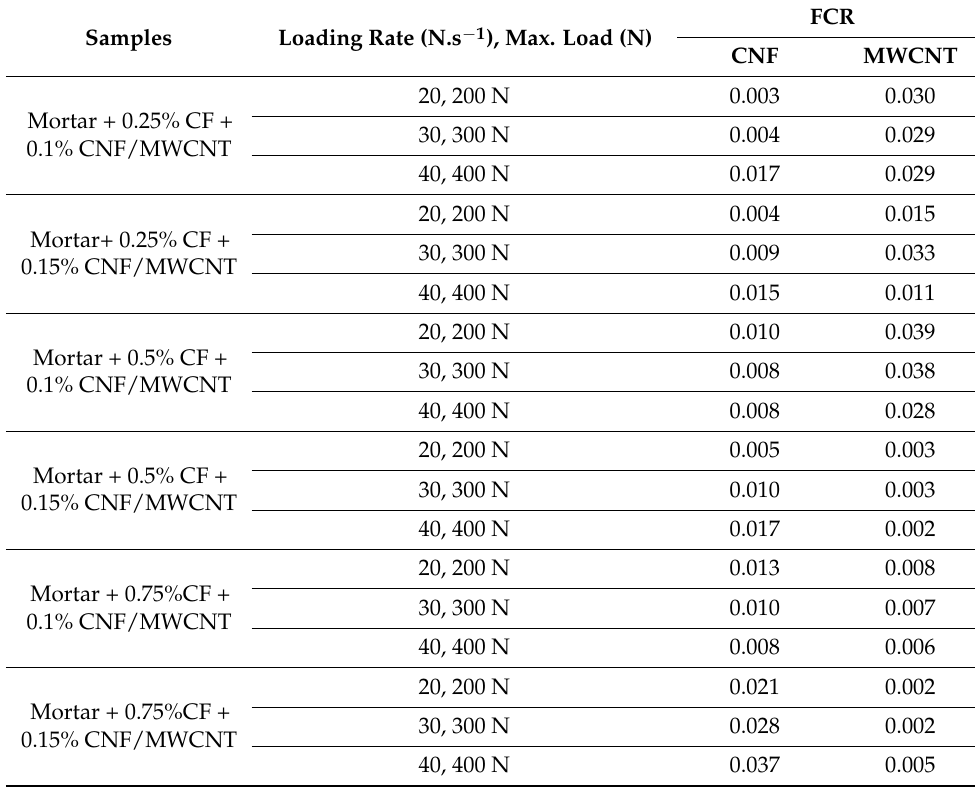
Table 5. Fractional resistance change of composites containing CF along with CNF/MWCNT.